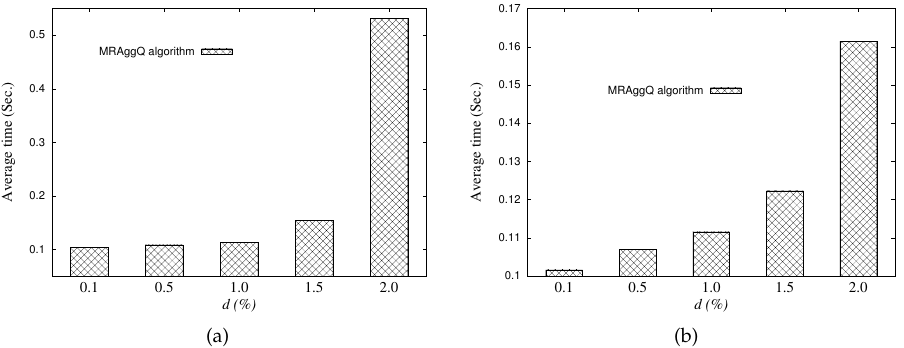
Figure 11. Effect of the distance d . ( a ) Uniform dataset; ( b ) Manchester